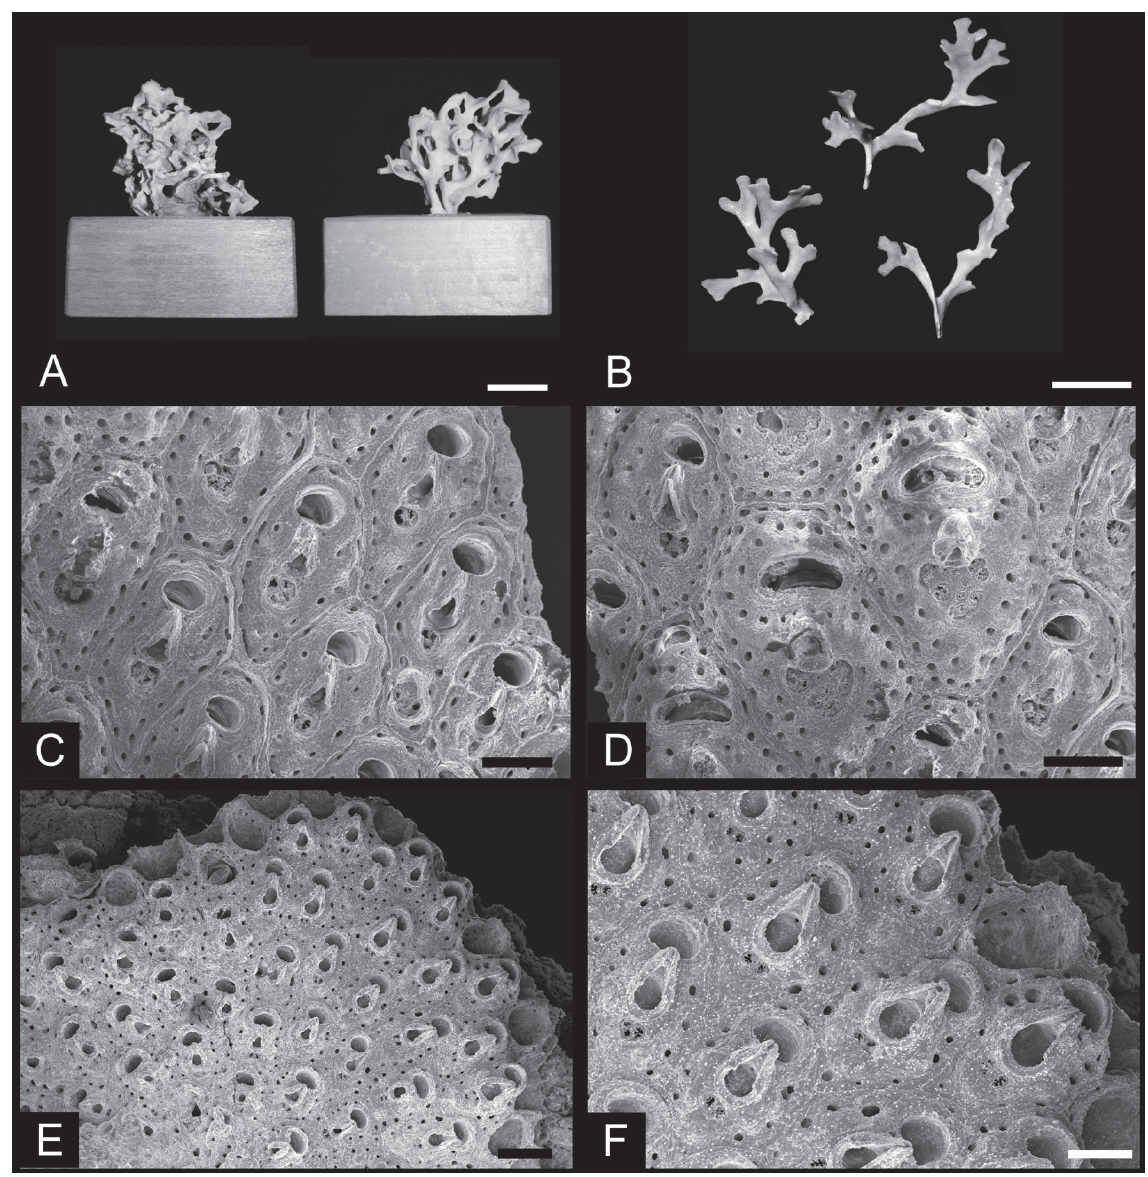
Fig. 12. Adeonellopsis sparassis (ortmann, 1890) . A . Left, lectotype (MZs 1-2); right, paralectotype (MZs 1-1) from among ortmann’s (1890) syntypes in the Döderlein Collection. B . Colonies collected at Tanegashima (NsMT-Te774). C . Autozooids (MZs 1-2) (NsMT-Te745). D . Gonozooids (MZs 1-2) (NsMT-Te745). E . Young, encrusting colony in showa emperor Collection (NsMT-Bryr362). F . enlargement showing young autozooids with small spiramen (NsMT-Bryr362). A–B = optical photographs; C–F = SEM images. Scale bars: A–B = 2 cm; C = 150 μm; D–E = 200 μm; F = 100